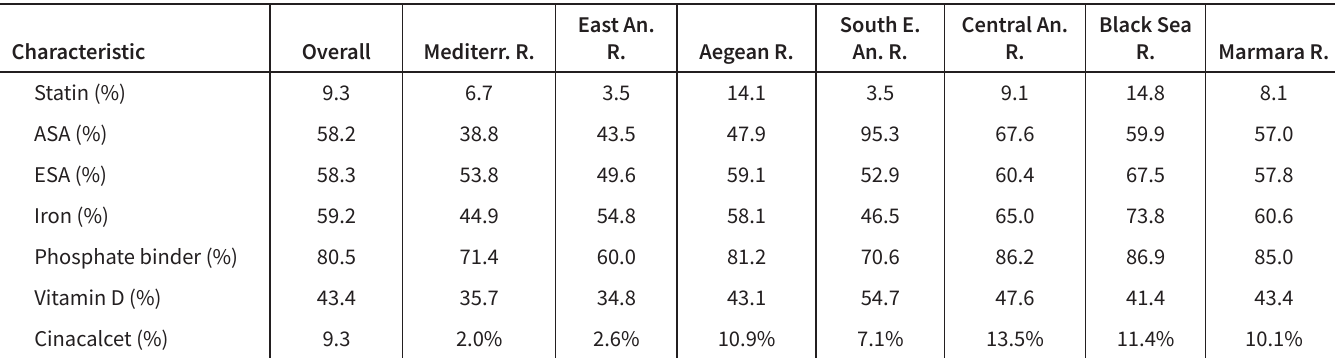
Table 1. Regional Distribution of Baseline Demographic and Clinical Characteristics of the Study Population ( Continued